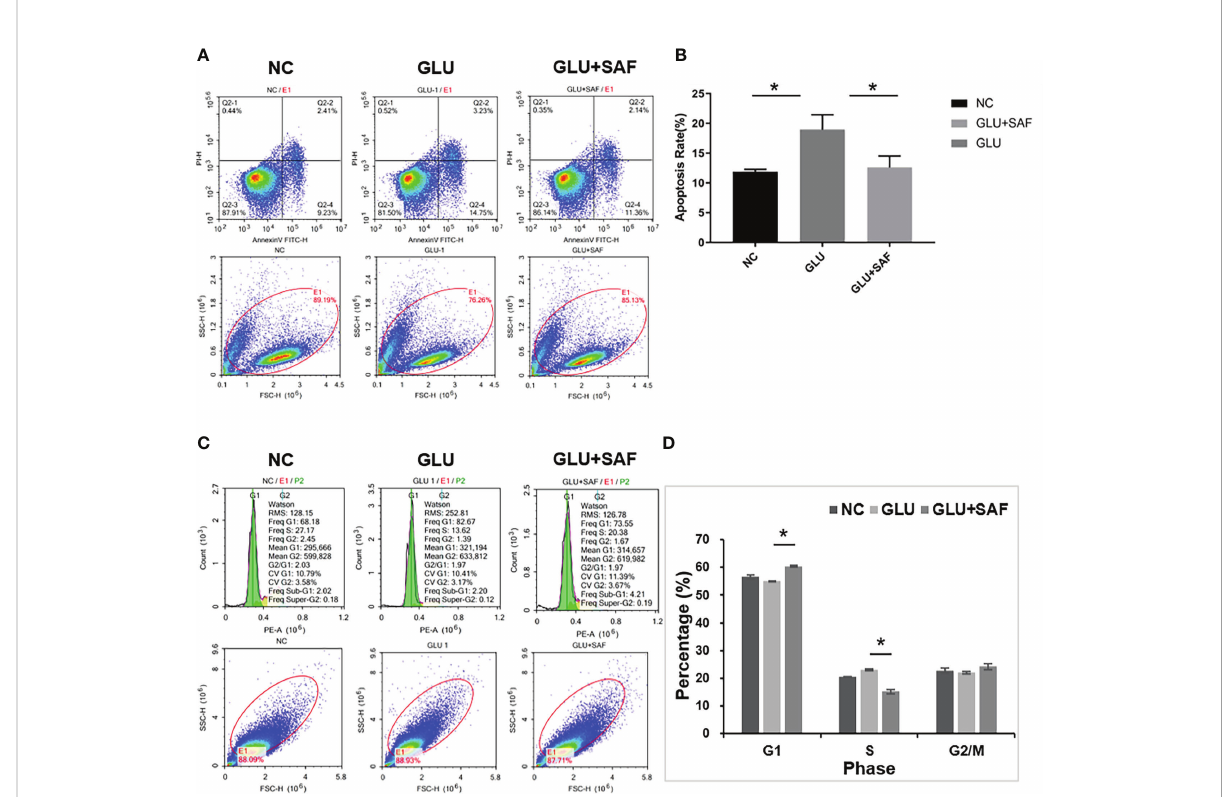
FIGURE 2 Flow cytometry results. The apoptosis rate varied indifferent groups:negative control, high glucose group, and high glucose group treated with safranal P=0.006, (A, B) . Regarding the cell cycle, compared with the high glucose group, there were more cells in phase G1 but fewer cells in phase S in the high glucose treated with safranal group P<0.001; (C, D) . * means a statistically signi fi cant